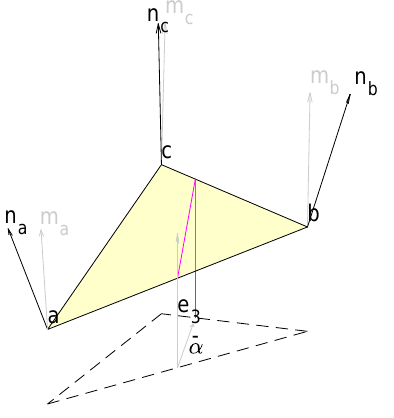
Figure A1. Left : Projection of vertex normals on the directional plane spanned by vectors ¯ α and e 3 . Right : Splitting of the raster rectangle ( a , b , c , d ) to four